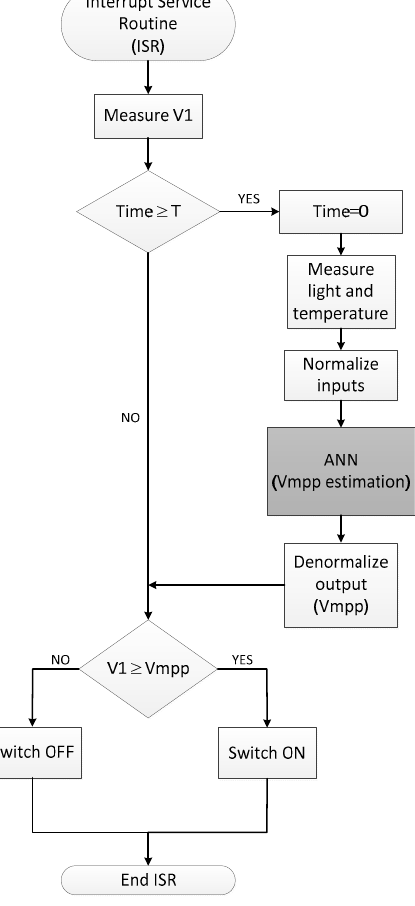
Figure 15. ANN-based VOC MPPT routine flow diagram.